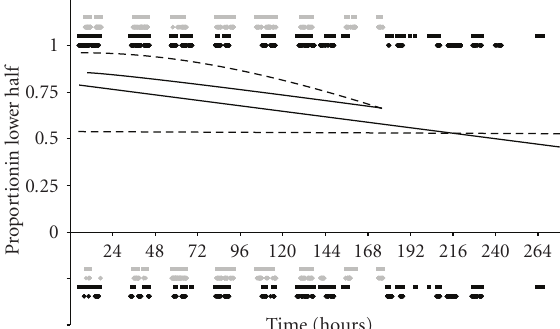
Figure 3: Observed activities and predicted proportions of restless behaviour over time (hours after the start of the experiment) among treatment and control reindeer from two source populations: domestic tame (Finnmark) and domestic wild (V˚ag˚a). Lines represent the estimates from zone 1 (the model intercept). Dashed and solid lines represent treatment animals and control animals, respectively. The two lower lines represent domestic tame animals, while the two upper represent domestic wild. The distributions of observations of restless and nonrestless behaviour are shown as symbols at the top and at the bottom, respectively. Black and grey symbols represent domestic tame and domestic wild, respectively. Circles and squares represent control and treatment animals, respectively.